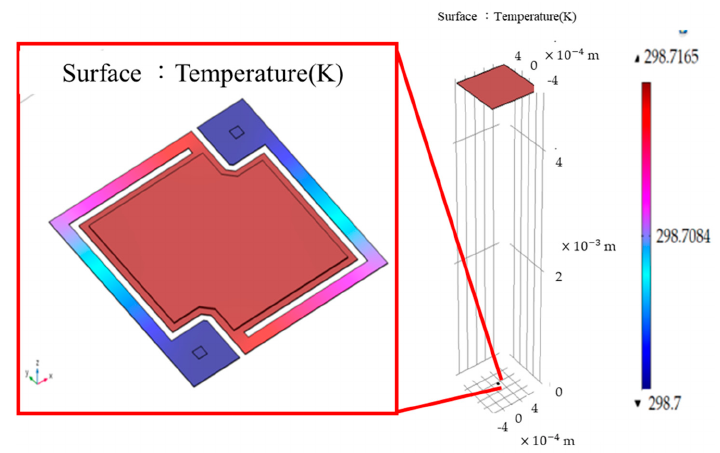
Figure 4. The simulated architecture for the illuminated microbolometer with pixel-pitch of 35 μ m.